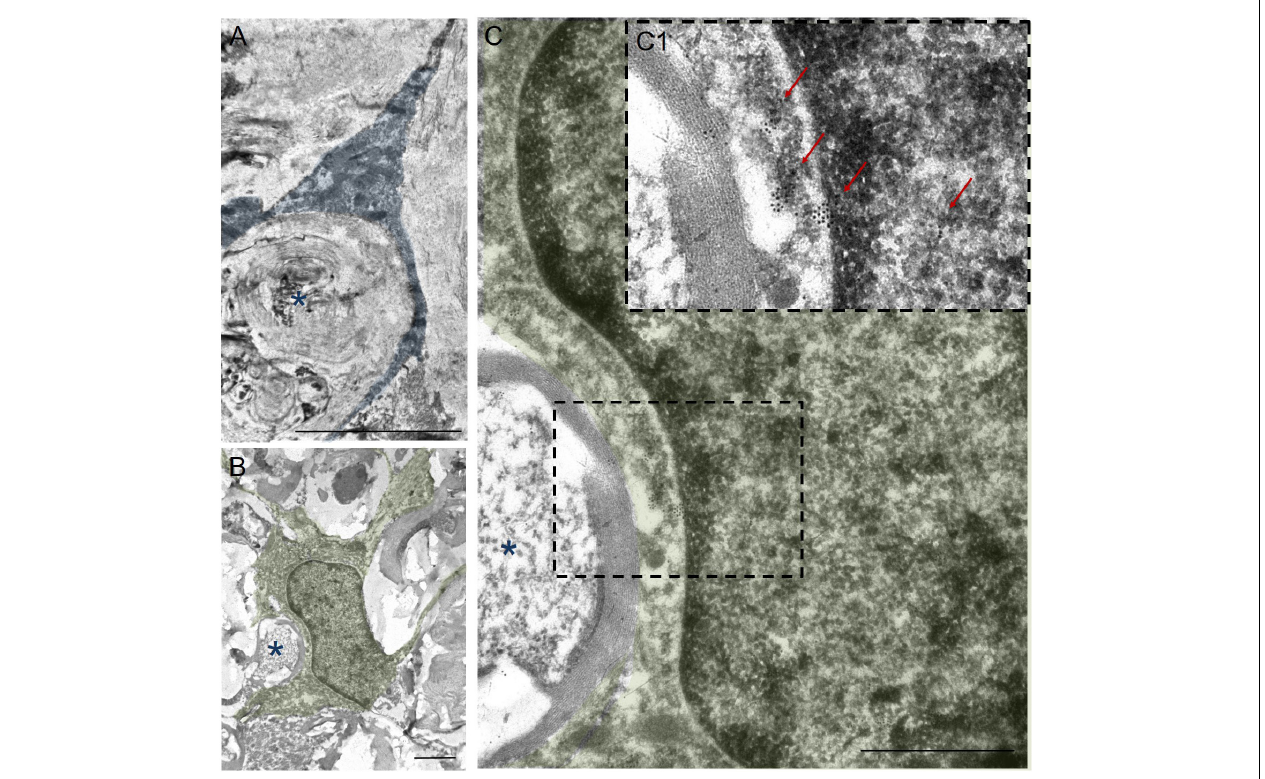
FIGURE 6 | Ultrastructure of annular-shaped microglia in SCI. Visualization of microglia ultrastructure using anti-Iba1 antibody within the ventral funiculi (VF) at 60 days after a mild contusion injury (the SCI 1.5 group). Positive immuno-peroxidase staining with anti-Iba1 antibodies in the cytoplasm of the microglia processes (marked in blue) surrounded disintegrating myelin fibers (asterisks) (A) . Positive immunocytochemical reaction with anti-Iba1 antibodies conjugated with gold nanoparticles (arrows) in the nucleus, perikarion, and processes of the microglia (marked in green) (B,C,C1) . The detected annular-shaped microglia had an increased electron density of the cytoplasm; the organelles were poorly visualized, but mitochondria with indistinctly distinguishable crystae were detected. The (C) area marked with dashed boxes corresponds to enlarged images of (C1) . Obtained sections evaluated using a transmission electron microscope (Hitachi HT7700). Scale bar: (A) 5, (B) 2, and (C) 1 µ